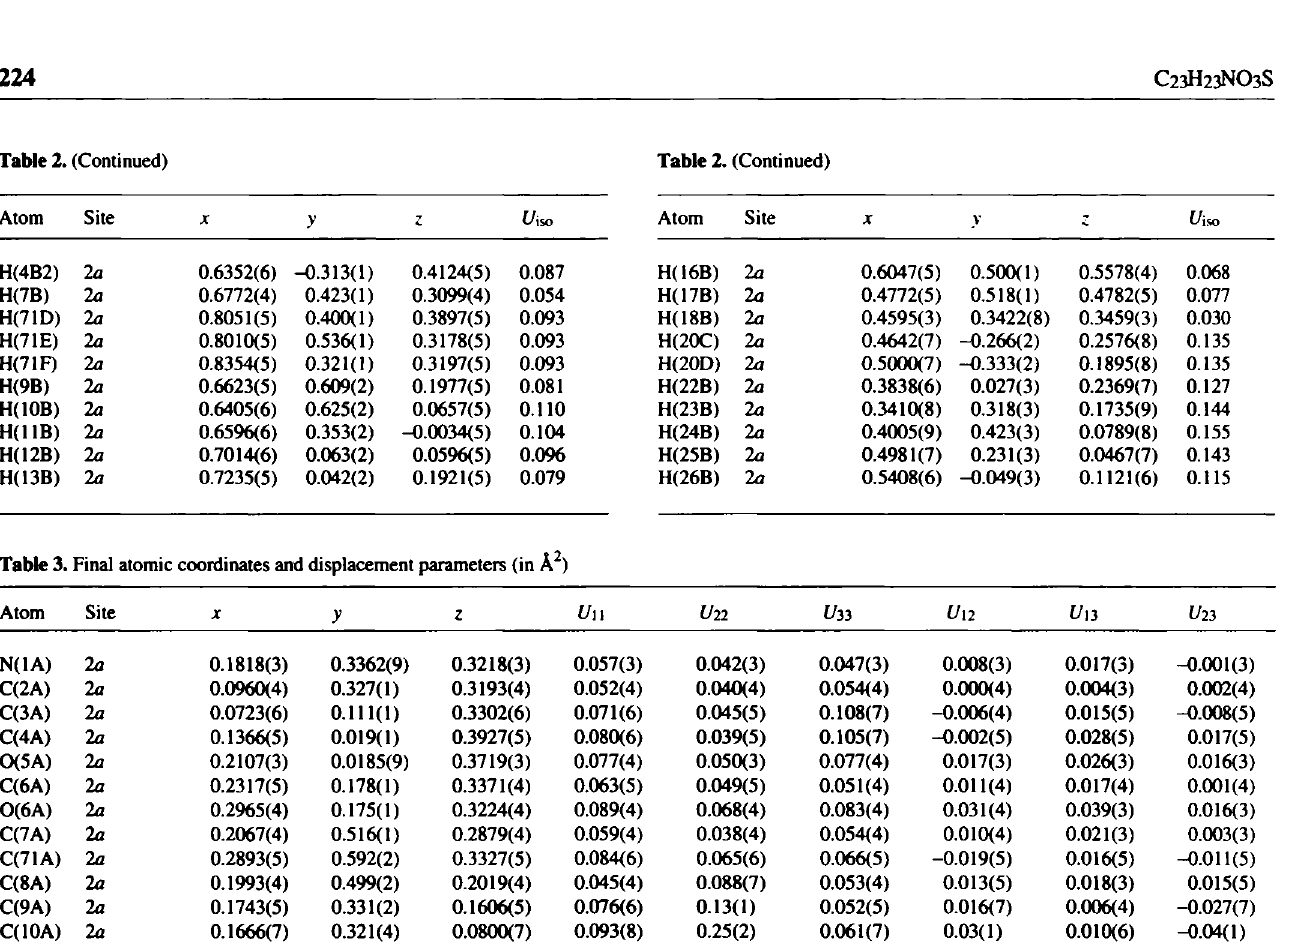
Table 3. Final atomic coordinates and displacement parameters (in Â 2